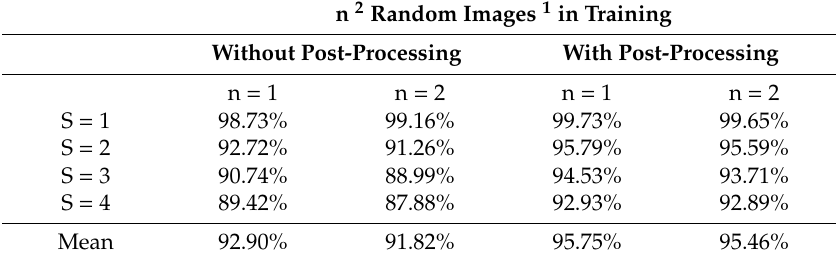
Table 7. Classification results of the experiment on the KTH-TIPS2b database for the four sets of 1188 images.